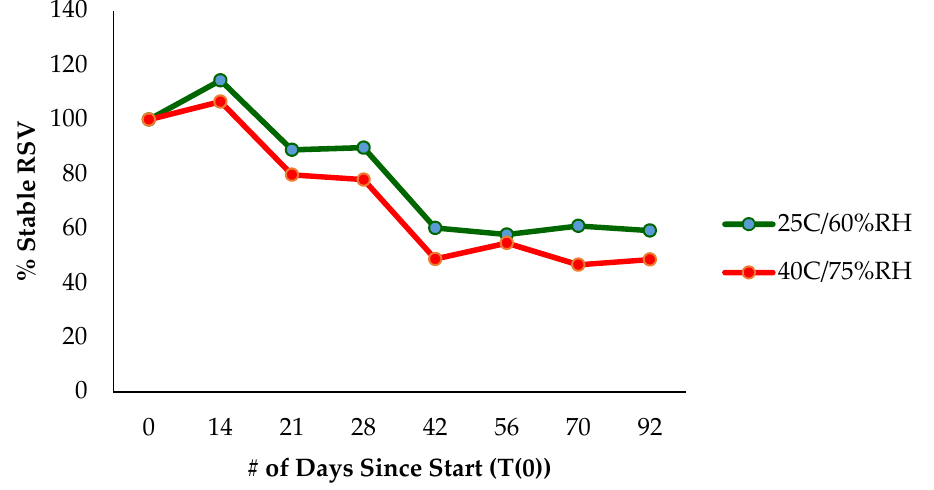
Figure 11. Cream stability studies, illustrating amount of stable resveratrol remaining.